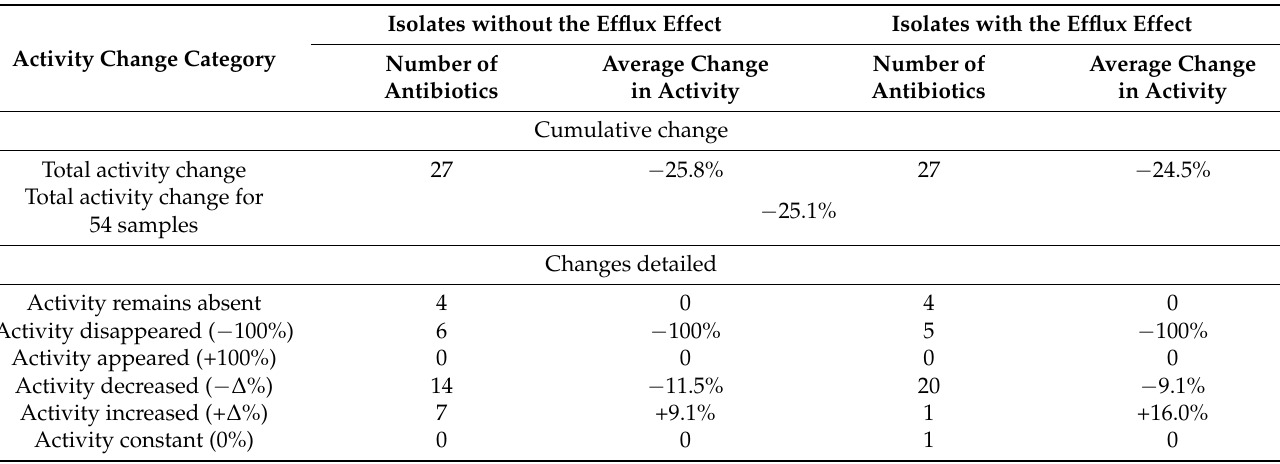
Table 2. Change in antibiotic activity towards S. aureus observed after treatment with Lactobay for isolates with and without the efflux